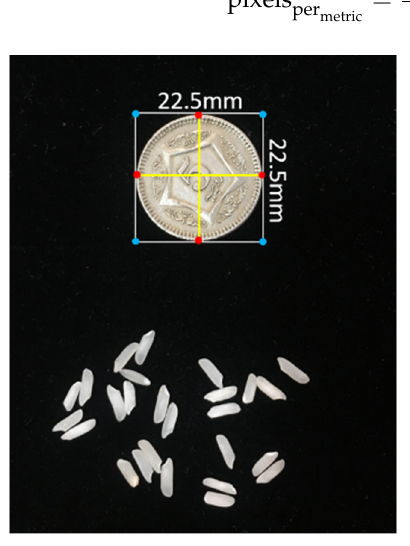
Figure 2. Calibration of the scanner using a coin.